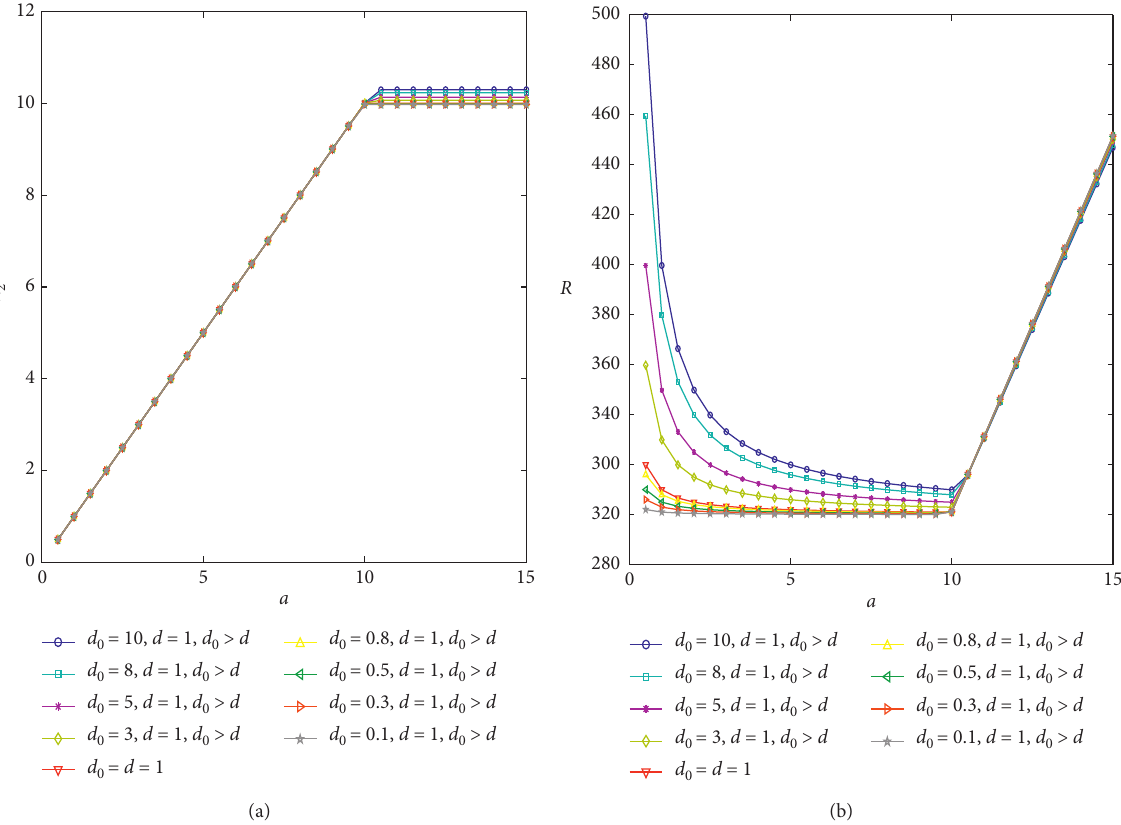
Figure 11: The synchronizability of multilayer star-ring networks vs . varying the intralayer coupling strength a ( N � 300, M � 10, and d � 1). (a) λ 2 with respect to varying a for different d 0 . (b) R with respect to varying a for different d 0